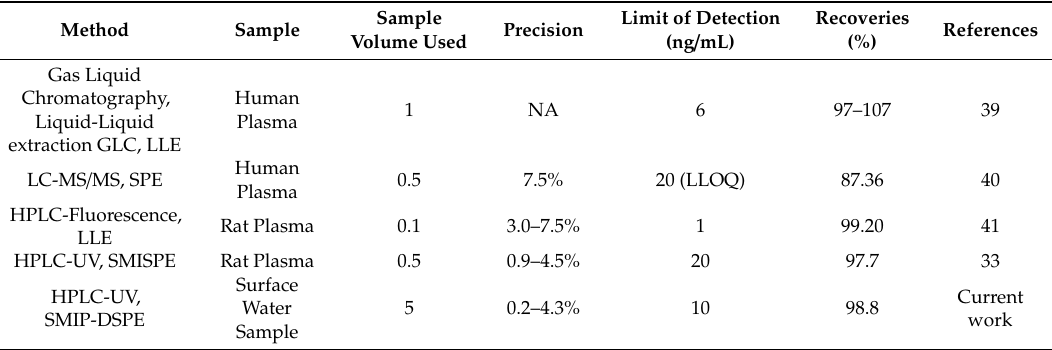
Table 2. Comparison with previous